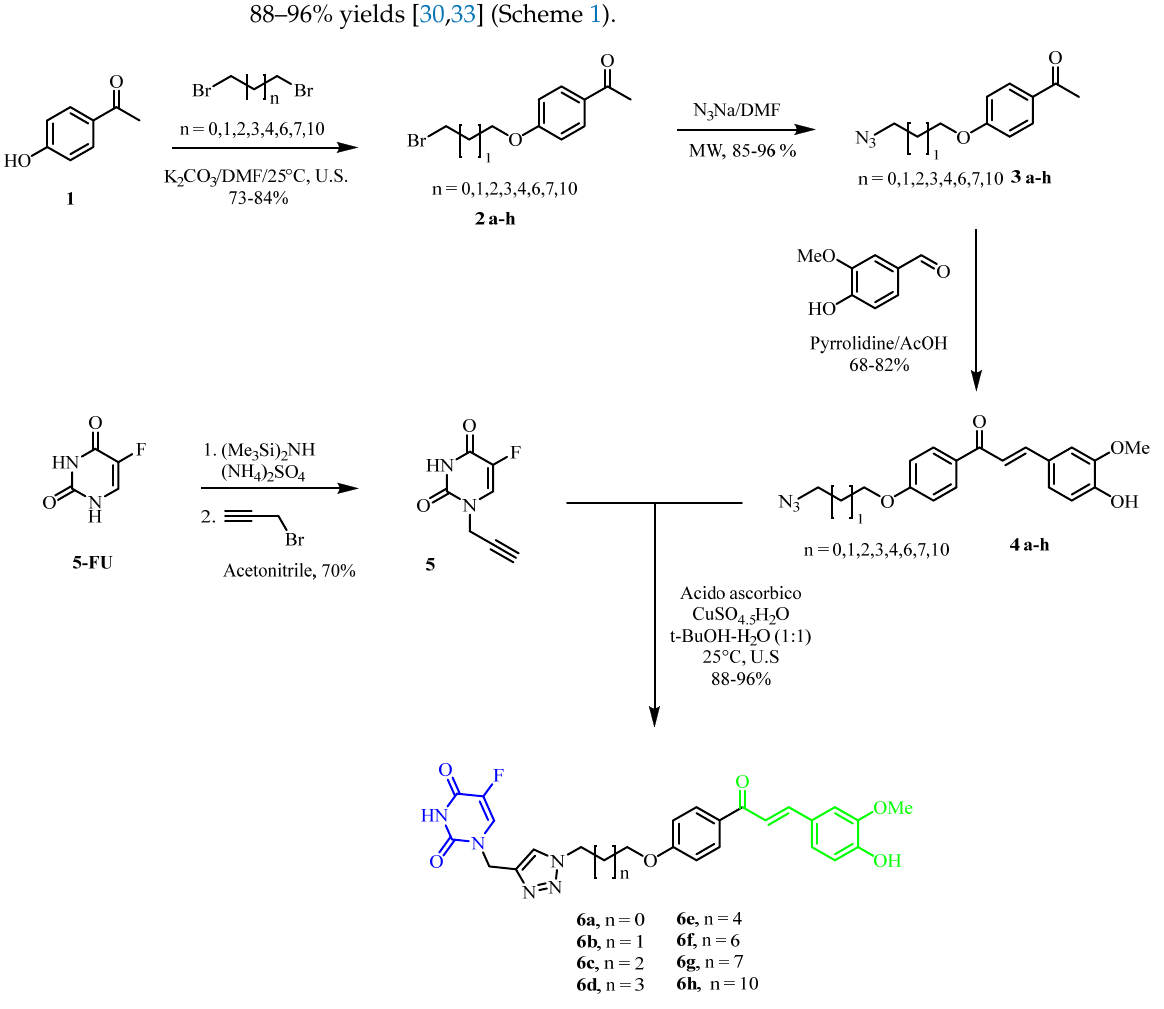
Scheme 1. Synthesis of hybrids based on 5-FU and